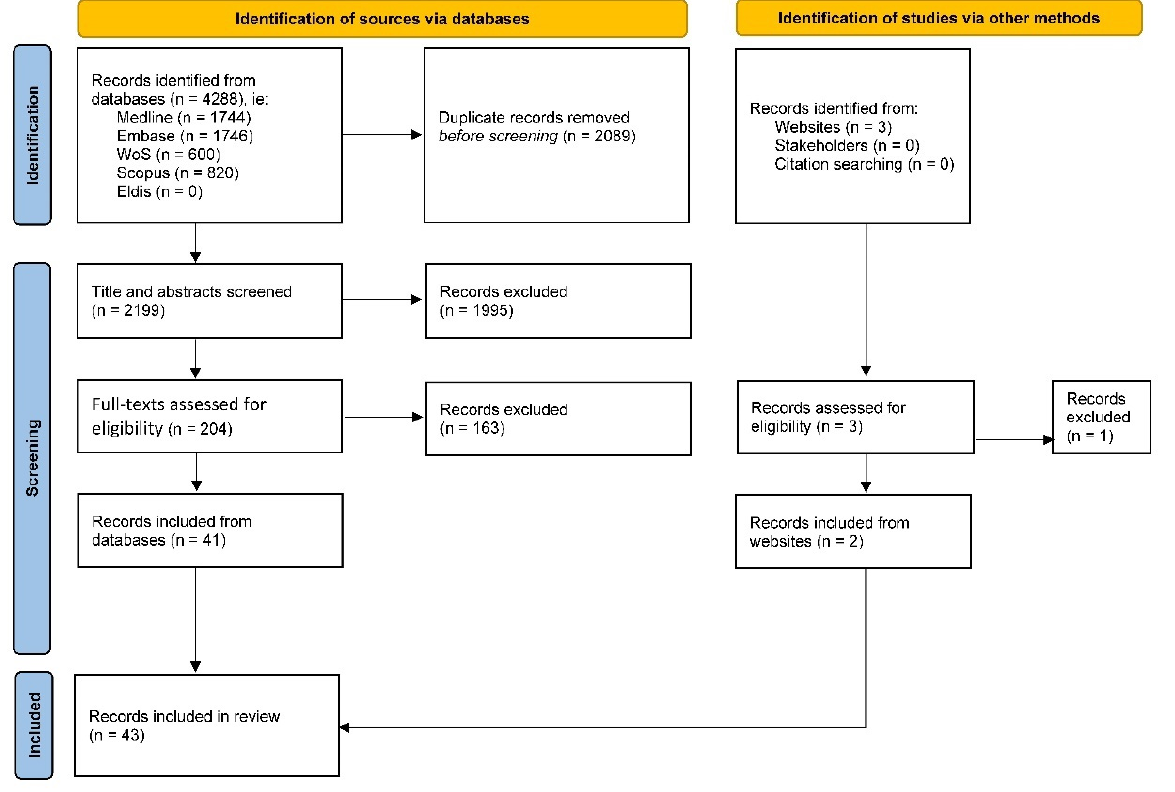
Figure 1. PRISMA flow diagram.